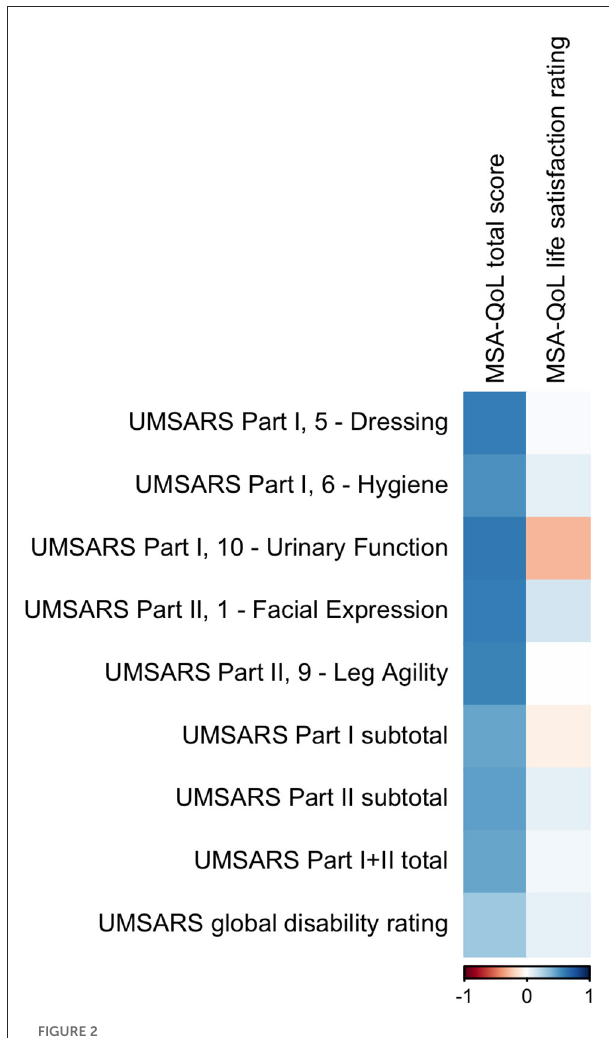
FIGURE2 A visual representation of the correlations between MSA-QoL domains and selected individual UMSARS items. A dark blue square represents a correlation coefficient that is close to 1 and a dark red square represents a correlation coefficient that is close to − 1, as shown in the